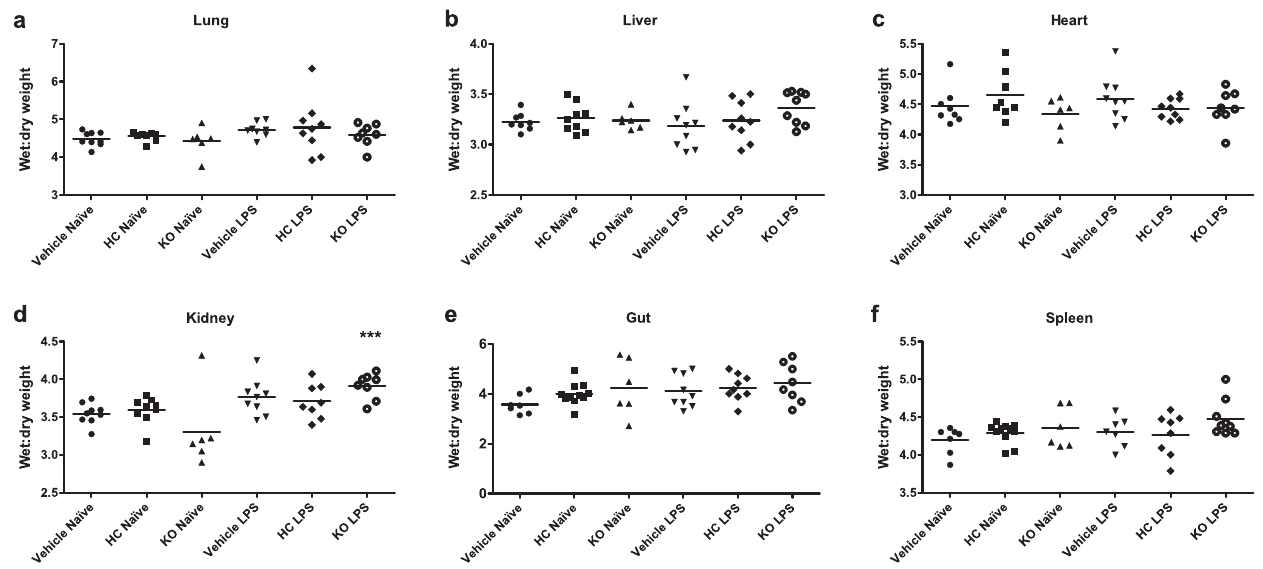
Figure 6. Oedema formation in TRPV4 WT and KO mice. Oedema formation was measured by comparing wet and dry weights of ( a ) lungs, ( b ) hearts, ( c ) upper liver lobes, ( d ) right kidneys, ( e ) 1-cm sections of small intestine and ( f ) whole spleens. WT mice were treated i.p. with vehicle (10% DMSO) or HC-067047 (HC) for 24 h, either under naïve or endotoxaemic (LPS 12.5 mg/kg, i.v., 24 h) conditions. Values for each animal are presented as individual symbols, with horizontal line denoting group mean. ***p<0.001, relative to naïve controls, 1-way ANOVA + Bonferroni post-hoc test (n = 6–9).